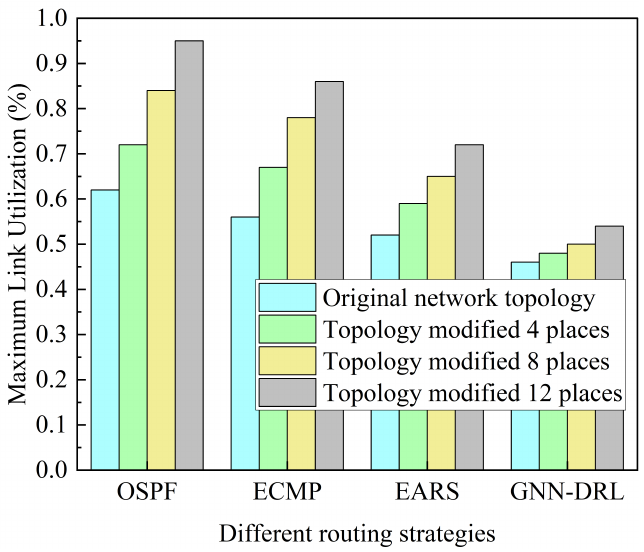
Figure 13. The effect of generalization on maximum link utilization.